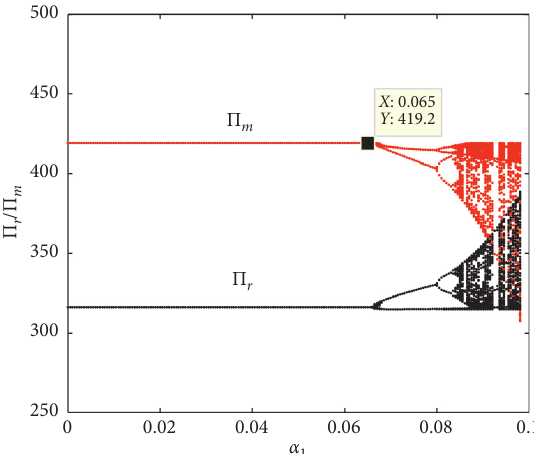
Figure 12: The bifurcation diagram of 􏽑